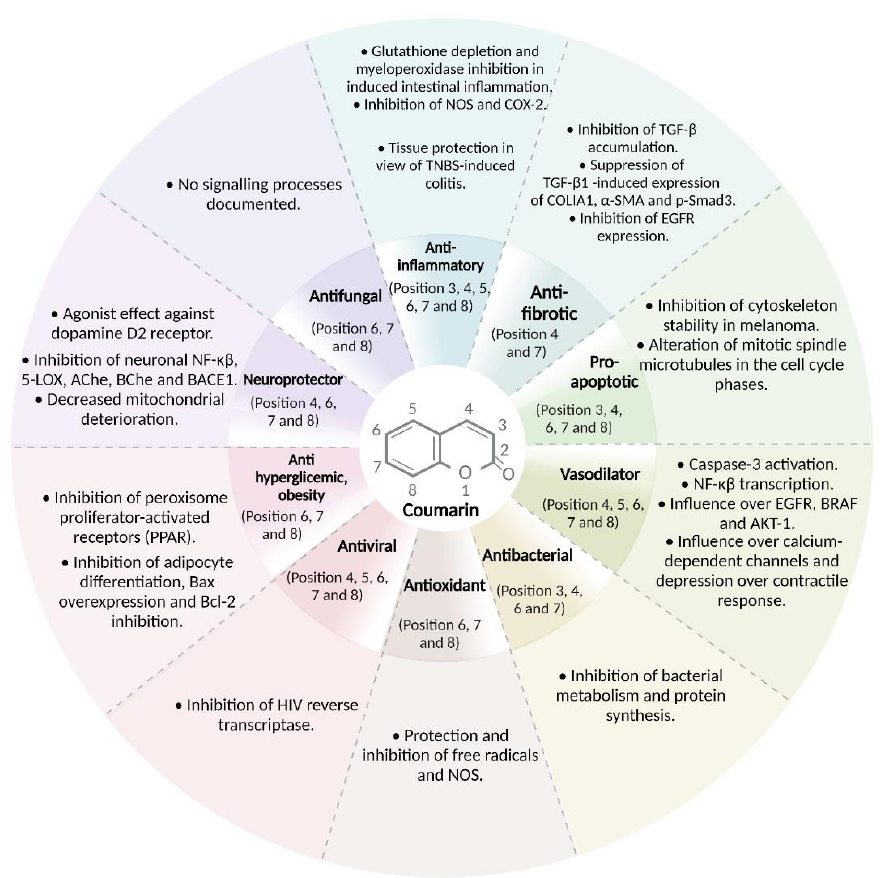
Figure 21. Coumarins substitution patterns and effects on the cell and molecular processes. Depend- ing on position of the substituent (from 1 to 8) on the coumarin ring, the coumarins possess the ability to regulate biological and pathological processes, as seen pathological processes such as inflammation and/or infectious diseases. Coumarins with substituents on 3, 4, 7, and 8 positions have been the most described to have influence over these pathological processes.